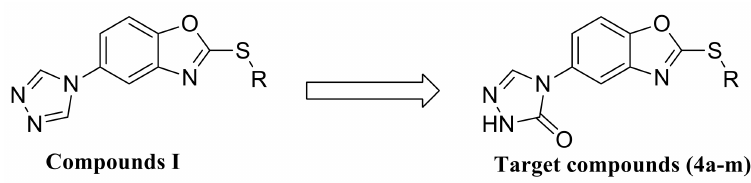
Figure 1. The leading compounds and target compounds ( 4a – m